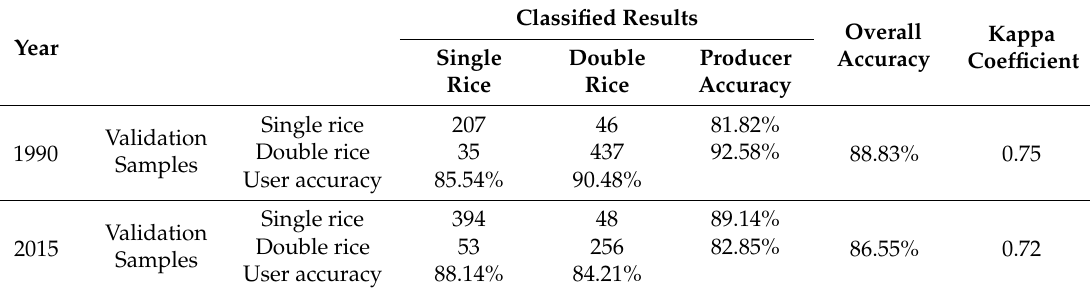
Table 1. Classification accuracy assessment.